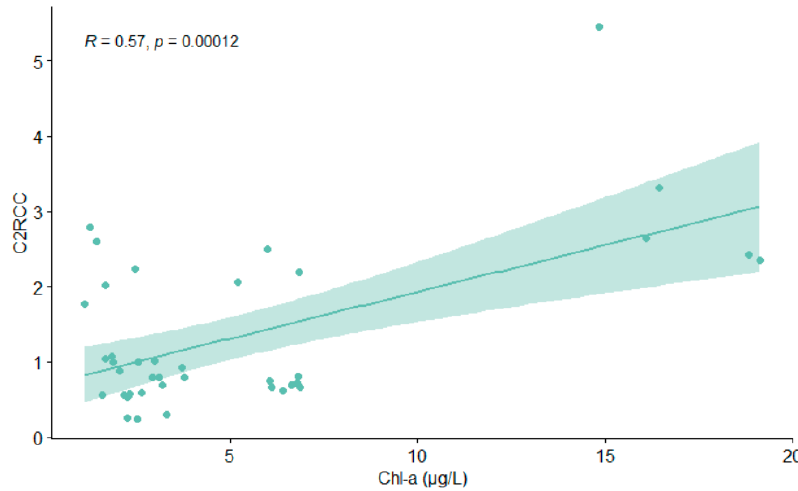
Figure 4. Correlation plot between C2RCC Chl-a concentration estimates and spectrophotometric measurements (with confidence bands).